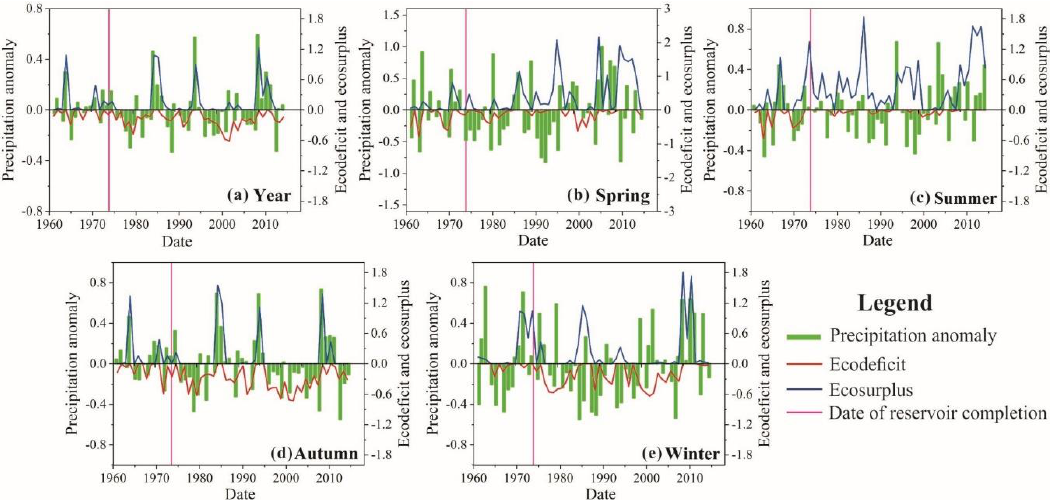
Figure 5. Variations in eco-flow indicators and precipitation anomalies: ( a ) year; ( b ) spring; ( c ) summer; ( d ) autumn; and ( e ) winter. Table 3. Correlation coe ffi cient between eco-flow indicators and precipitation before and after the SWR. Correlation Coe ffi